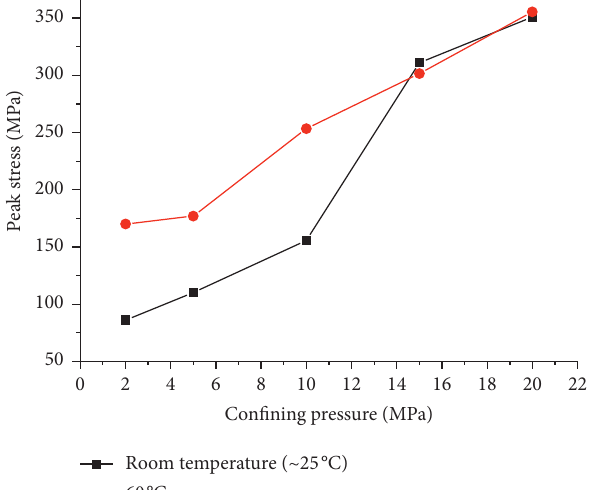
Figure 3: The effects of confining pressure (2, 5, 10, 15,